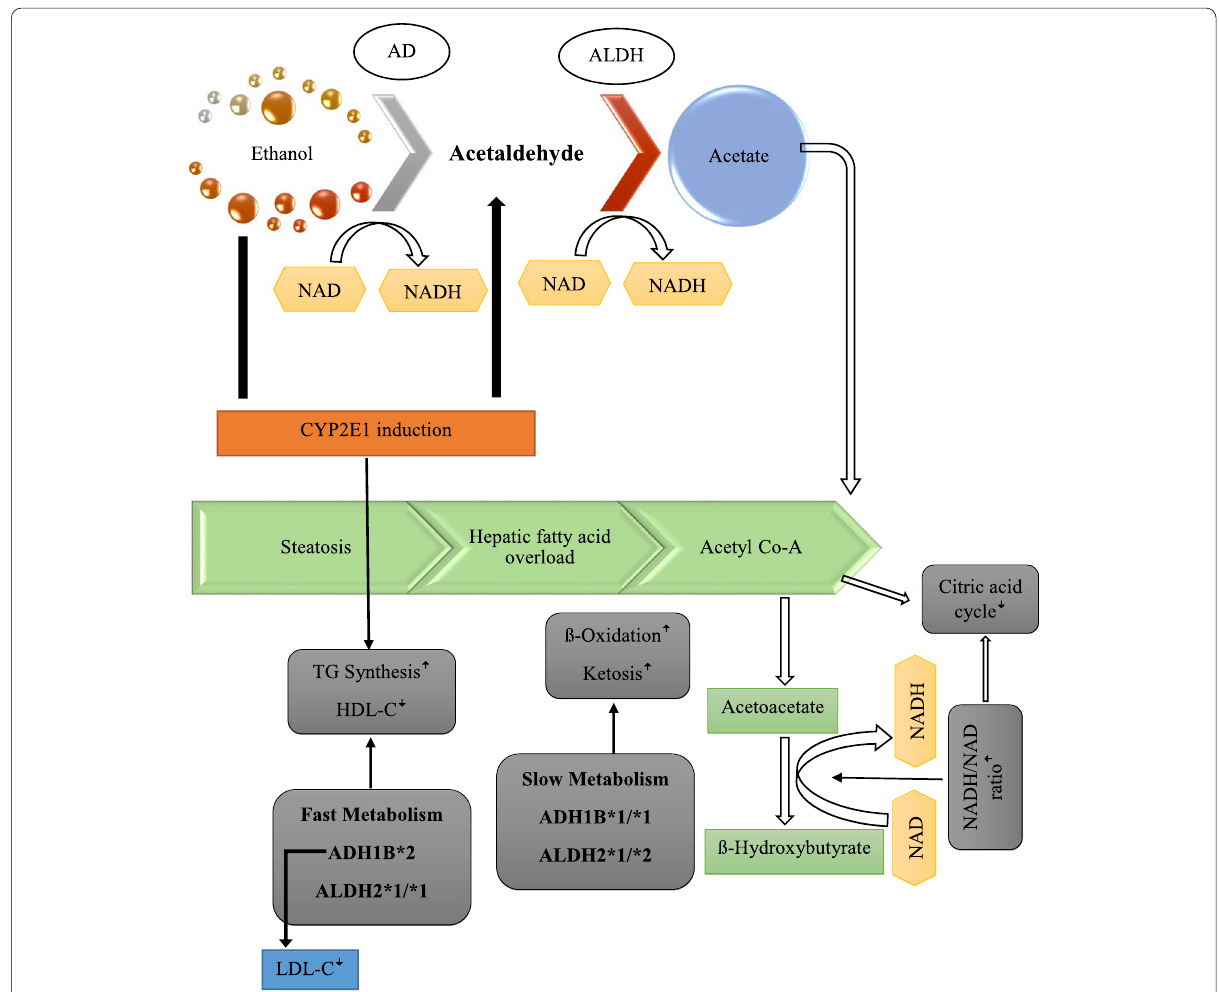
Fig. 6 Metabolism of ethanol and lipids and alcohol-metabolizing enzymes in